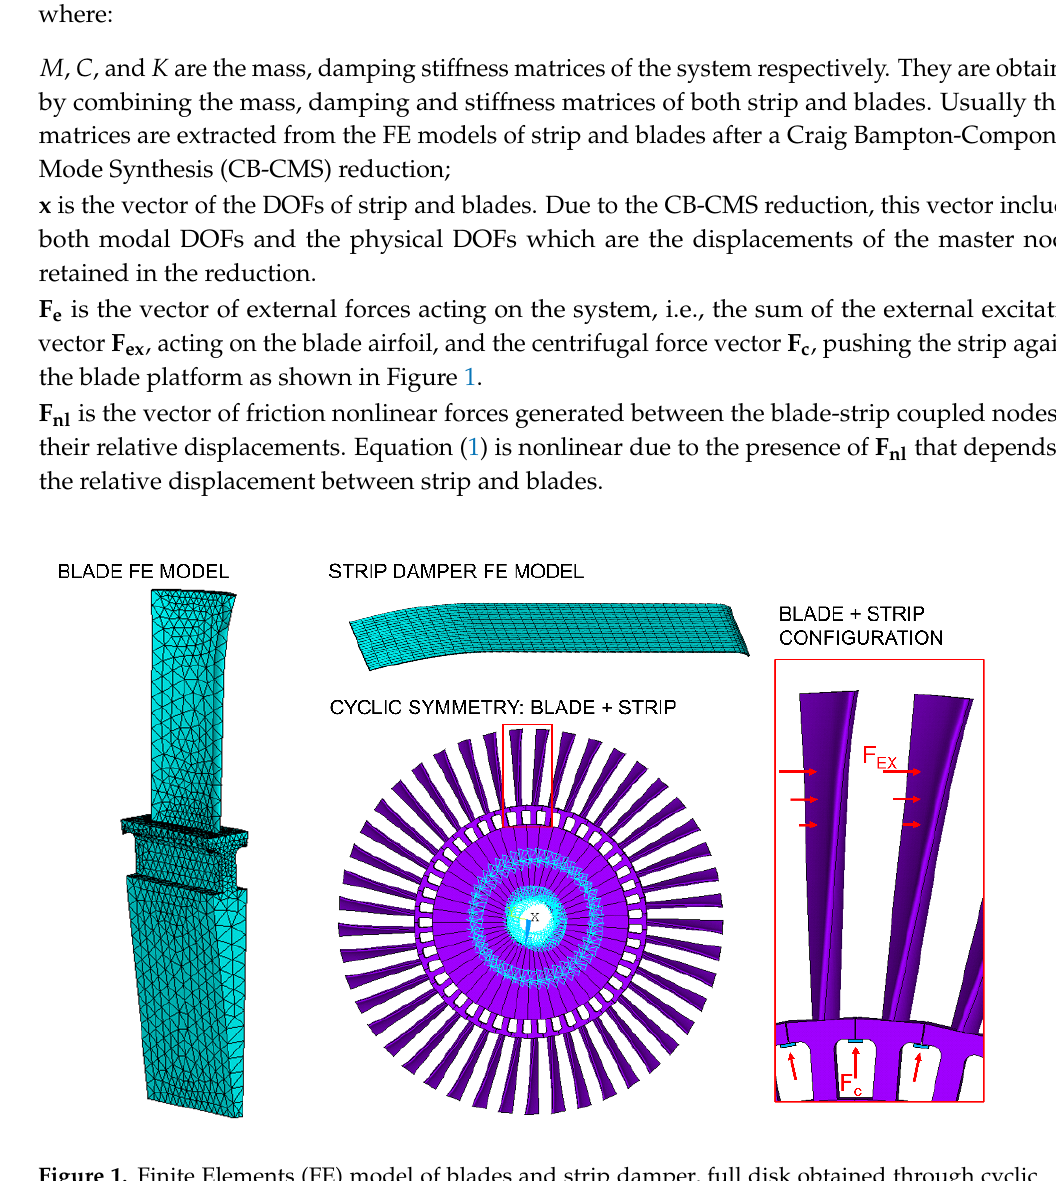
Figure 1. Finite Elements (FE) model of blades and strip damper, full disk obtained through cyclic symmetry and relevant external forces applied on blades and strip dampers. The cyan symbols represent the boundary conditions imposed to the disk sector: each sector is tangentially linked to the neighbouring ones and is rigidly connected to the disk hub, not shown in the